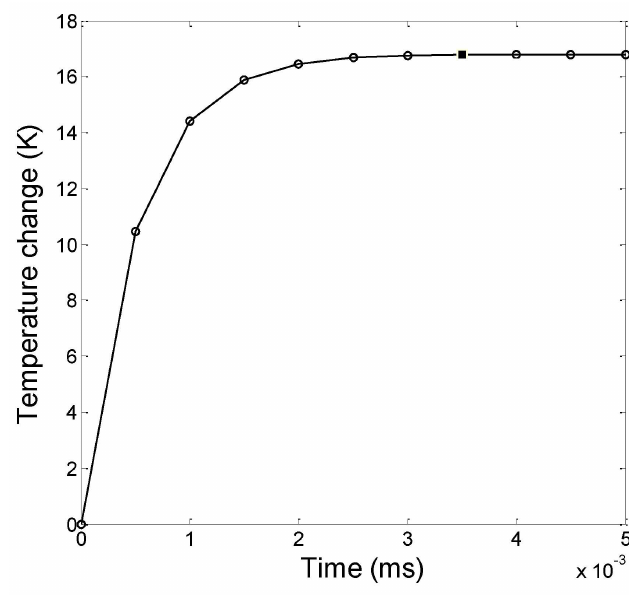
Figure 6. Transient response of the temperature on the cantilever beam simulated using